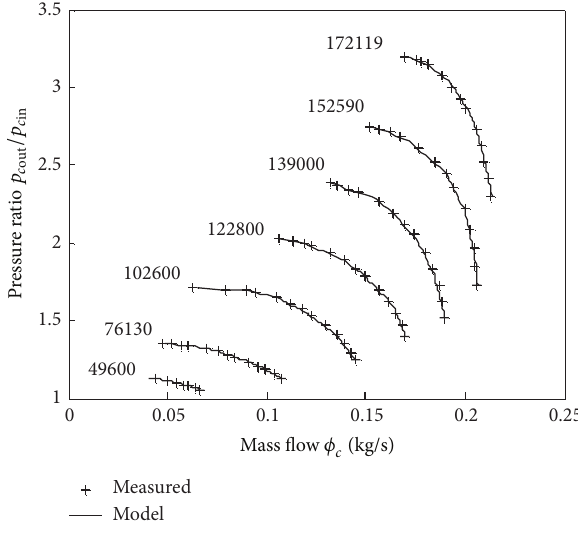
Figure 3: Mass flow model for compressor at stationary engine condition (the unit of compressor speed is